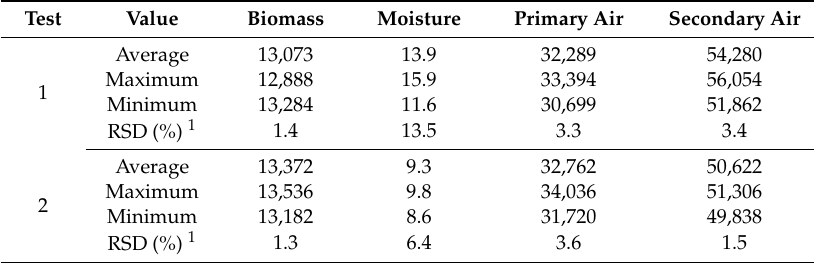
Table 1. Biomass and air flow rates (kg / h) and biomass moisture (wt.%) during the experimental campaigns performed. Test Value Biomass Moisture Primary Air Secondary Air